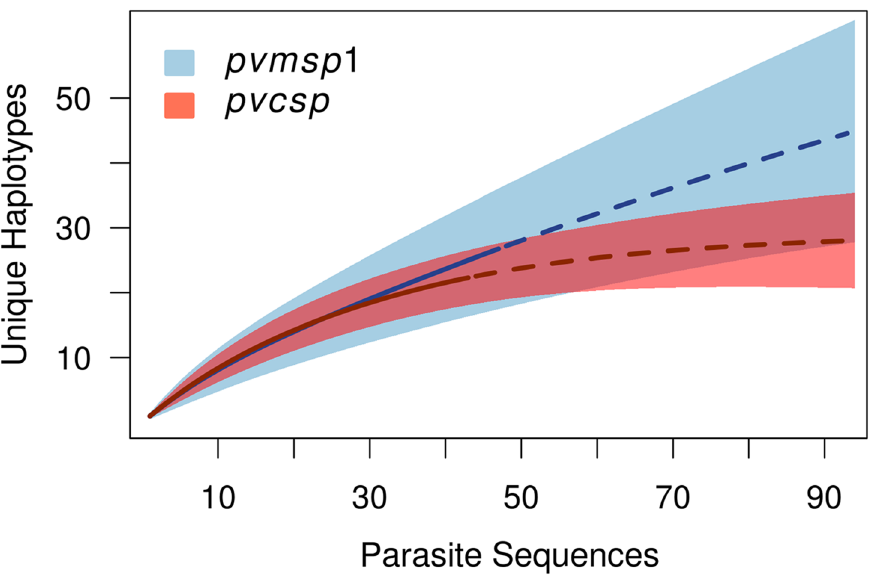
Figure 2. Haplotype rarefaction curves for the Cambodian cohort. Calculated rarefaction curves are depicted by solid blue ( pvmsp-1 ) and red ( pvcsp ) lines. Dotted lines represent rarefaction values extrapolated according to the methods of Cowell, et al. The 95% CIs of rarefaction estimates for pvmsp-1 and pvcsp are demarked by light blue and light red shaded areas, respectively.